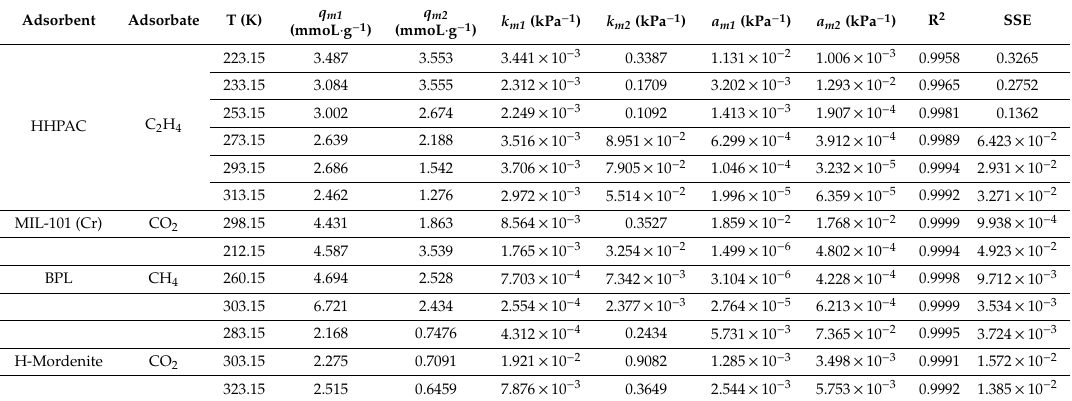
Table 8. The modified DSL (M-DSL) model parameters and errors for di ff erent systems at di ff erent